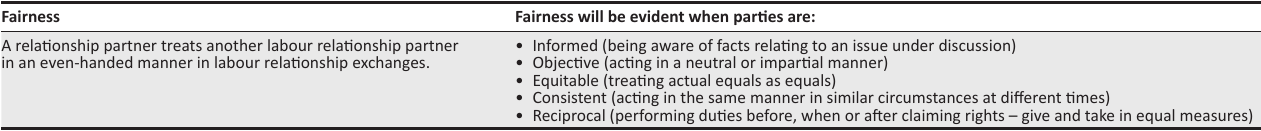
TABLE 3: Criteria for assessing fairness in labour relationships.